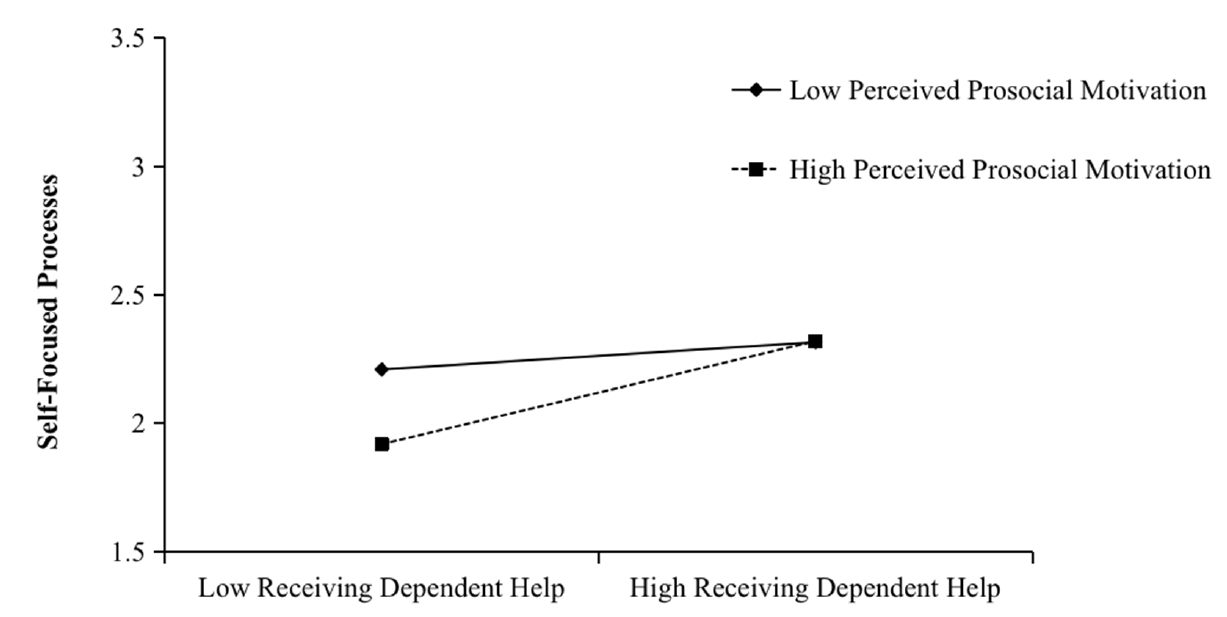
Figure 3. Moderating effect of perceived prosocial motivation on the relationship between receiving dependent help and self-focused processes. Table 5. Conditional Indirect Effect Results.